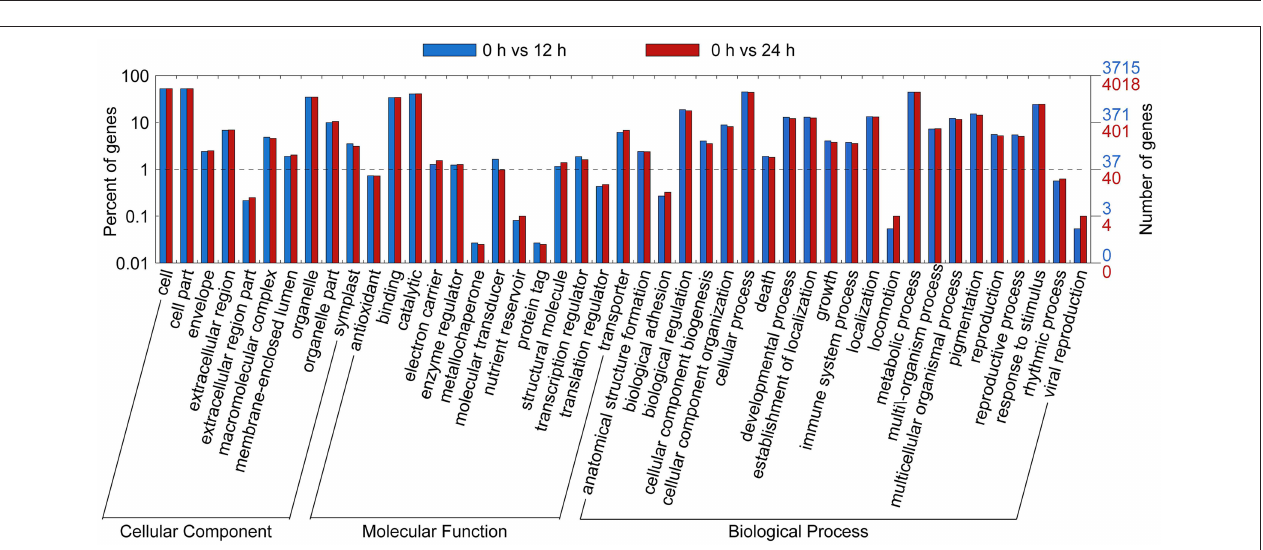
FIGURE 2 | Genes significantly differentially expressed in response to SA treatment. (A), The up- and down-regulated transcript numbers during SA treatment. X -axis represents pairwise and Y -axis means number of screened DETs. Green bar denotes down-regulated genes and red bar for the up-regulated. (B) , The Venn diagram analysis of the quantity of the DETs identified at different time points of SA treatment.